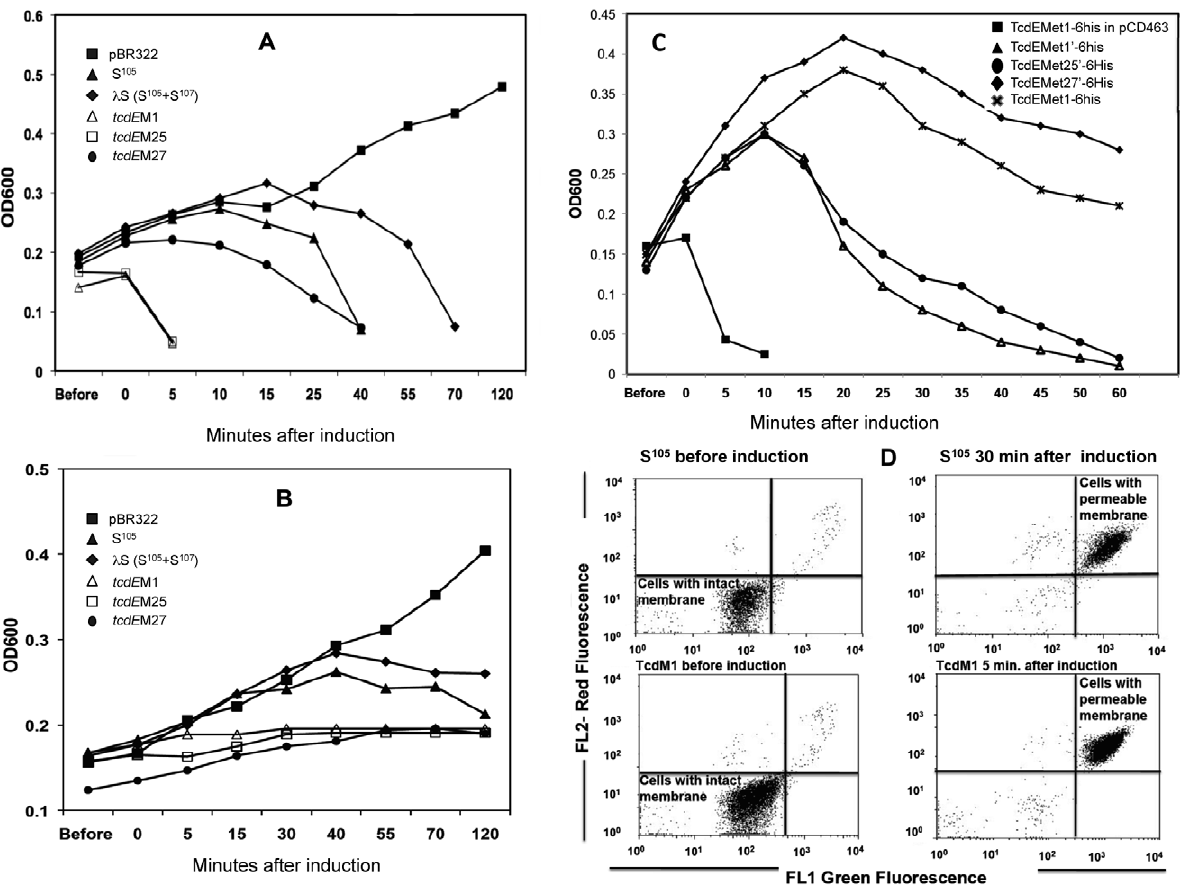
Figure 8. Testing holin function of TcdE in E.coli . Lysis curves of lysogenic cultures carrying l cI 857 Sam7 ( A ) or l Cmr D (SR) ( B ) and plasmids expressing in trans l S , S 105 ,TcdEM1, TcdEM25, and TcdEM27, respectively. A lysogenic strain carrying pBR322 was used as negative control. C. Lysis curve of E. coli l cI 857 Sam7 lysogen carrying plasmids expressing TcdEM1 in pCD463, TcdEMet1, TcdEMet1’, TcdEMet25’ and TcdEMet27’ respectively. D. FACS analysis of E. coli l Cmr D (SR) lysogens expressing either S 105 or TcdEM1 through propidium idodide (PI) and SYTO9 staining.